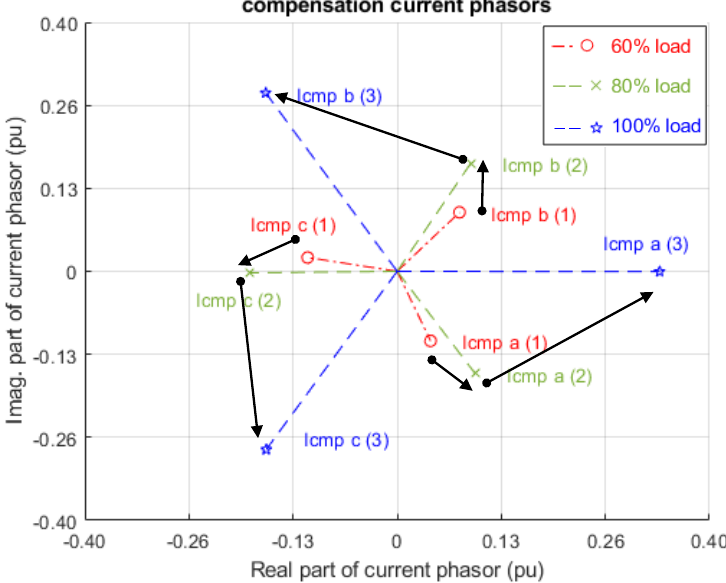
Figure 10. The compensation current phasors relating to increasing capacitive load (the current base was 757.6 A).